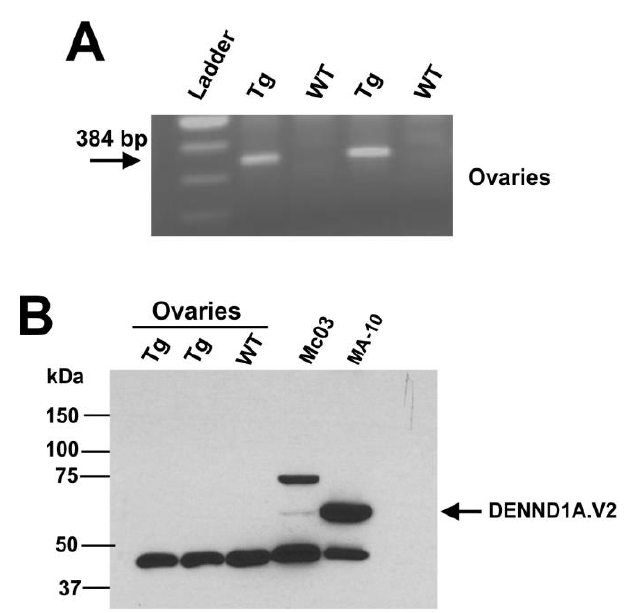
Figure 8. The Lhcgr -hDENND1A.V2 transgenic mouse profile. ( A ) Representative RT-PCR results from ovaries collected from wild-type and transgenic mice. ( B ) Representative immunodetection on Western blots for hDENND1A.V2 protein in transgenic mice. A total of 100 μg protein was loaded in the wells containing protein extracts from whole mouse ovaries, 25 μg for Mc03, and 20 μg for MA-10 cells. WT, wild-type; Tg, transgenic; Mc03 human theca cells, cultured human theca cells from a PCOS subject (positive control); MA-10, transfected cells using the p Lhcgr -hDENND1A.V2 construct (positive control).